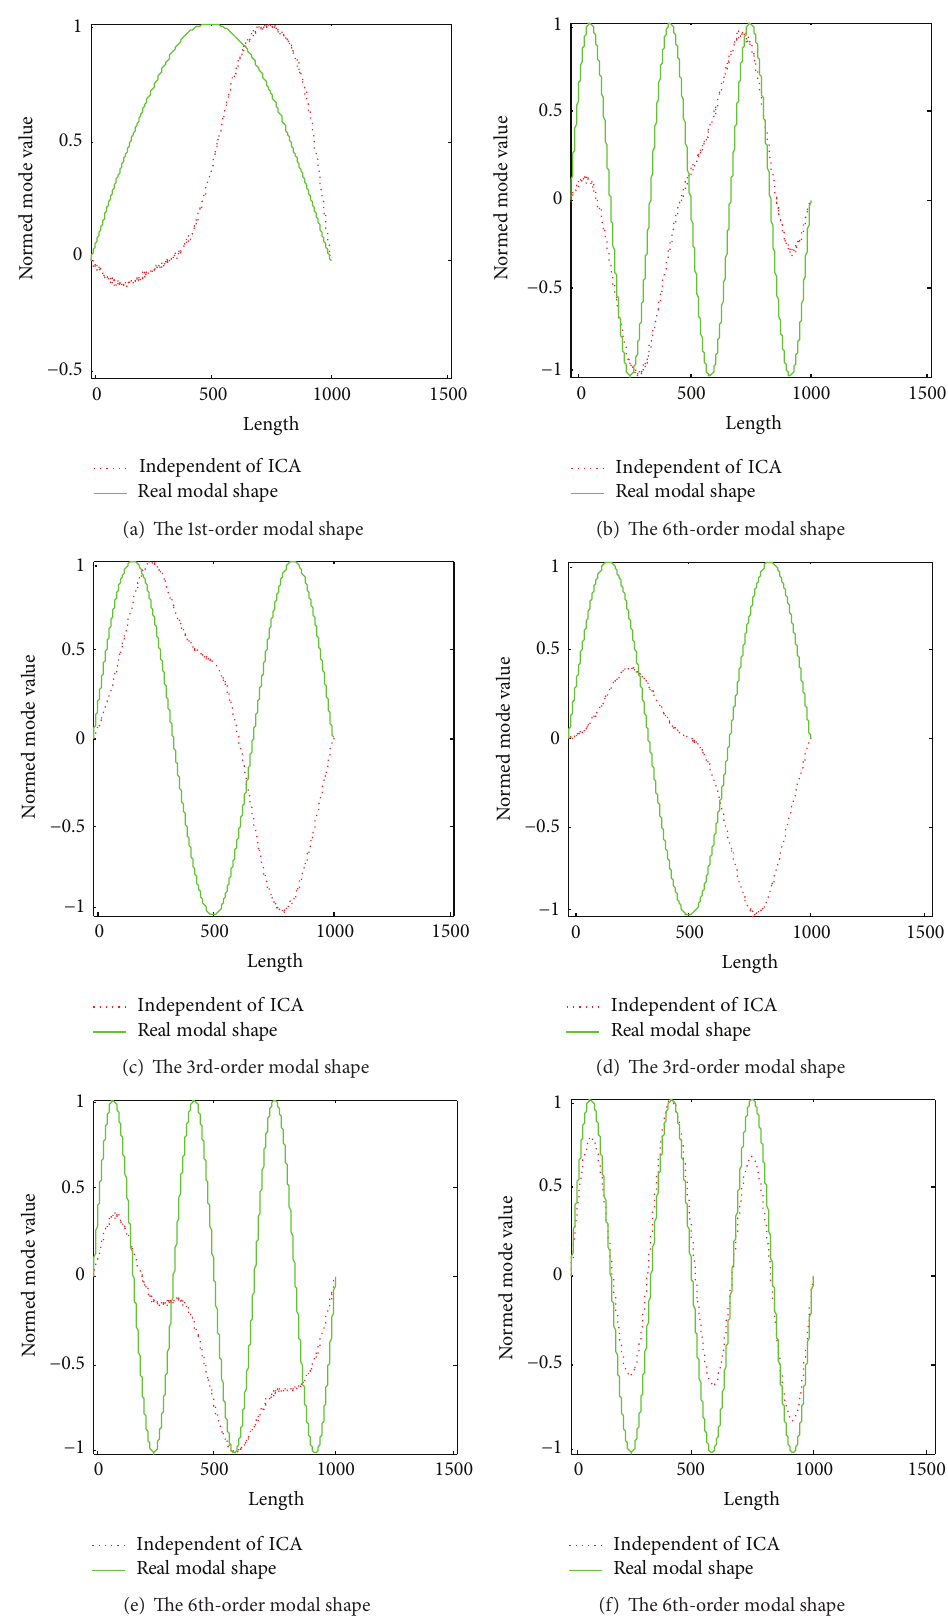
Figure 14: Modal shape comparison between FEA and separating vector by maximization kurtosis with gradient descent method with measurement